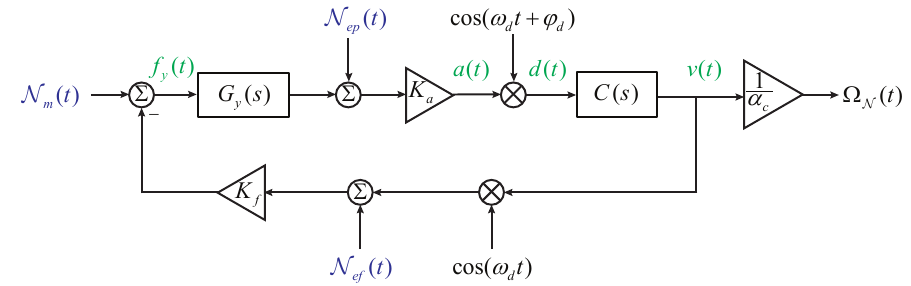
Figure 8. The block diagram of the force-rebalance noise